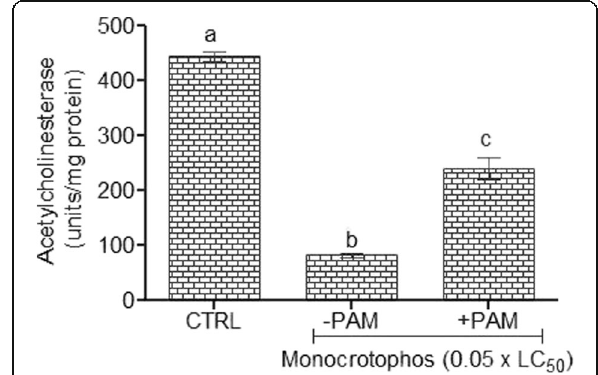
Fig. 6 Effect of pralidoxime (PAM, 20 mM) on AChE inhibition by monocrotophos in Caenorhabditis elegans . Bars with different letter are significantly different from each other ( p < 0.001)